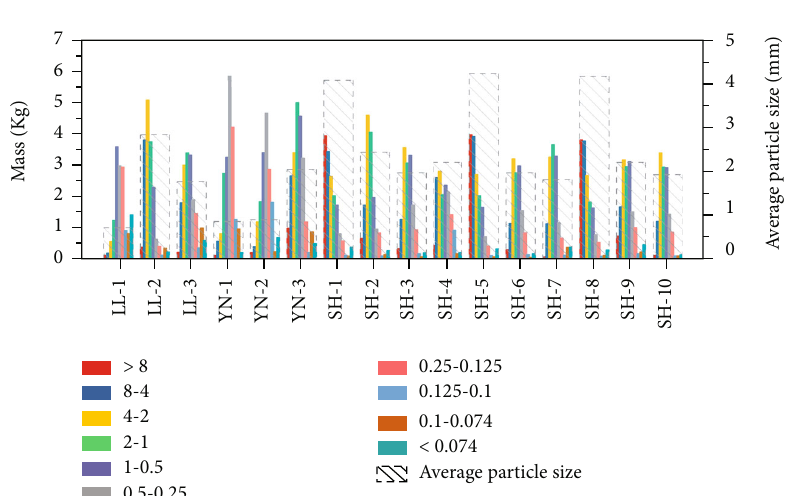
Figure 5: Histogram of particle size distribution of drill